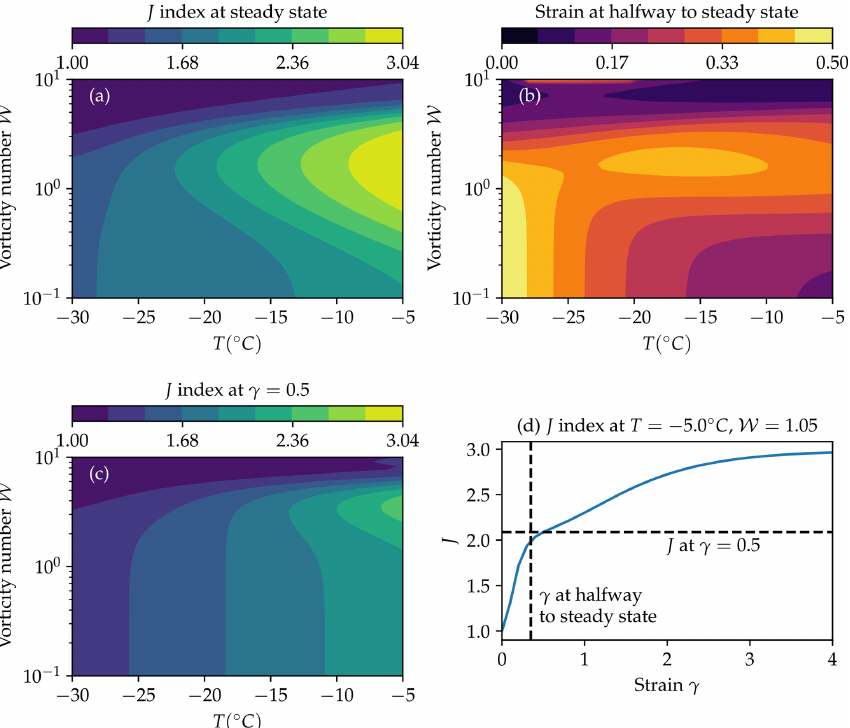
Figure 13. Properties of steady-state fabrics across the W – T parameter space. (a) shows the J index at the steady state. (b) shows the finite strain required to reach halfway to the steady-state value of J . (c) shows the J index at a strain of γ = 0 . 5. (d) shows the plot of J against strain γ , illustrating the strain at halfway to steady state and J index at γ = 0 .